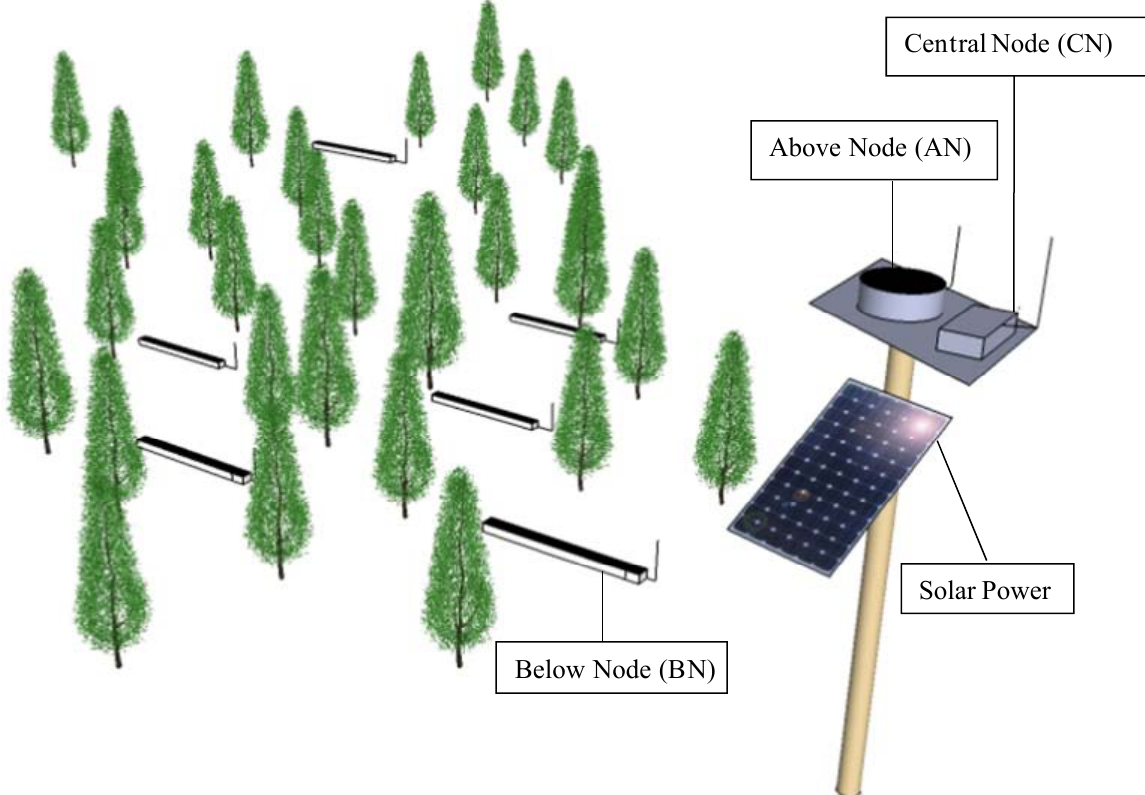
Figure 1. The schematic map of MLAOS